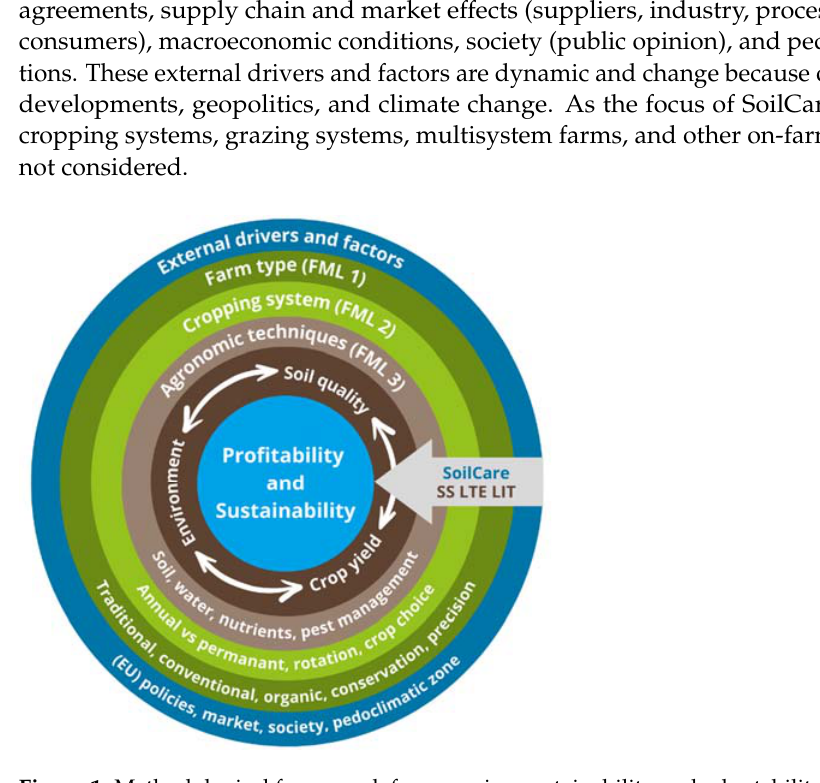
Figure 1. Methodological framework for assessing sustainability and adoptability of soil-improving cropping systems, showing the influence of farm management levels (FML 1–3) on soil quality, environment, crop yield, profitability, and sustainability. LIT refers to literature and other published data, LTE to long-term experiments, and SS to work in the study sites.